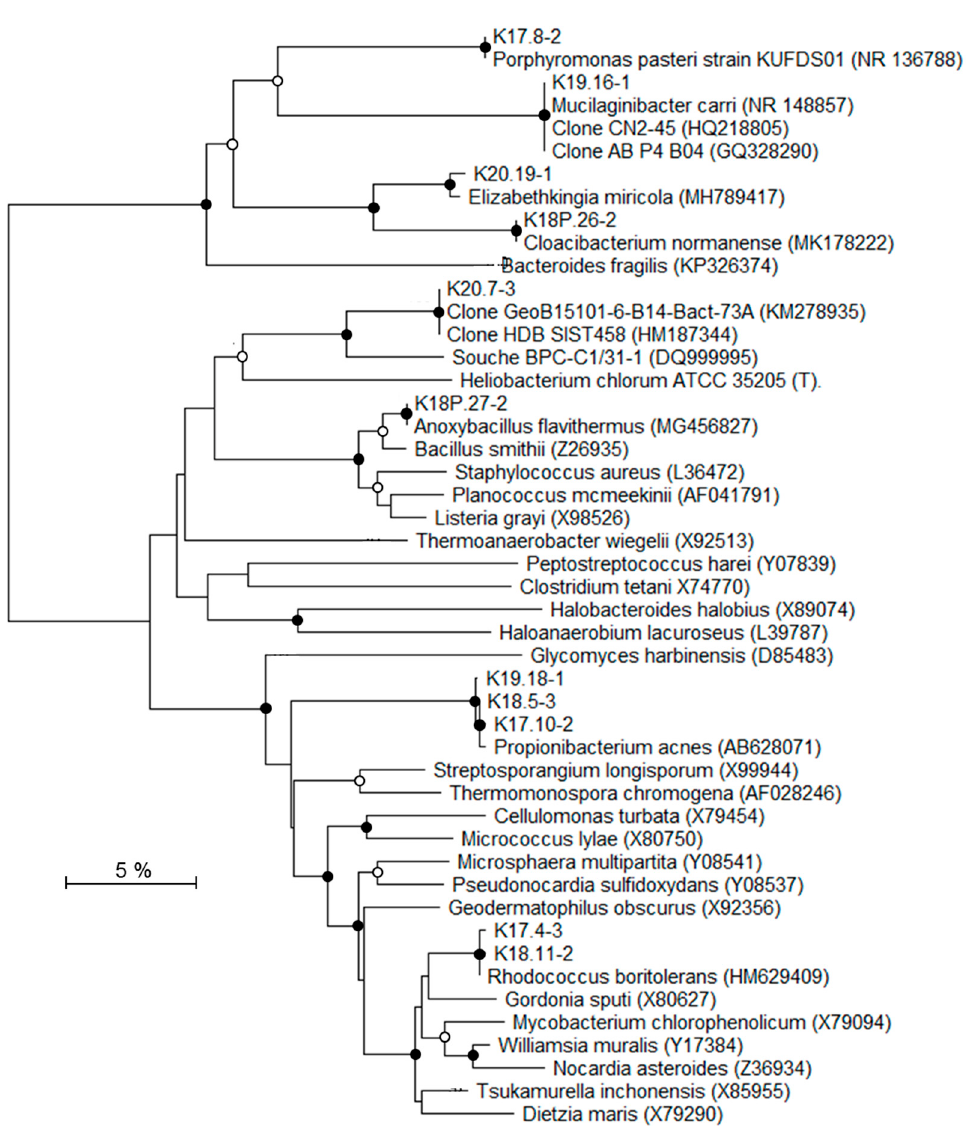
Figure 7. Phylogenetic tree showing the relationships of recovered 16S rRNA gene sequences (excluding Proteobacteria -related sequences) with reference Genbank sequences. Black circles: bootstrap > 70%; white circles: 50% < bootstrap < 70% (1000